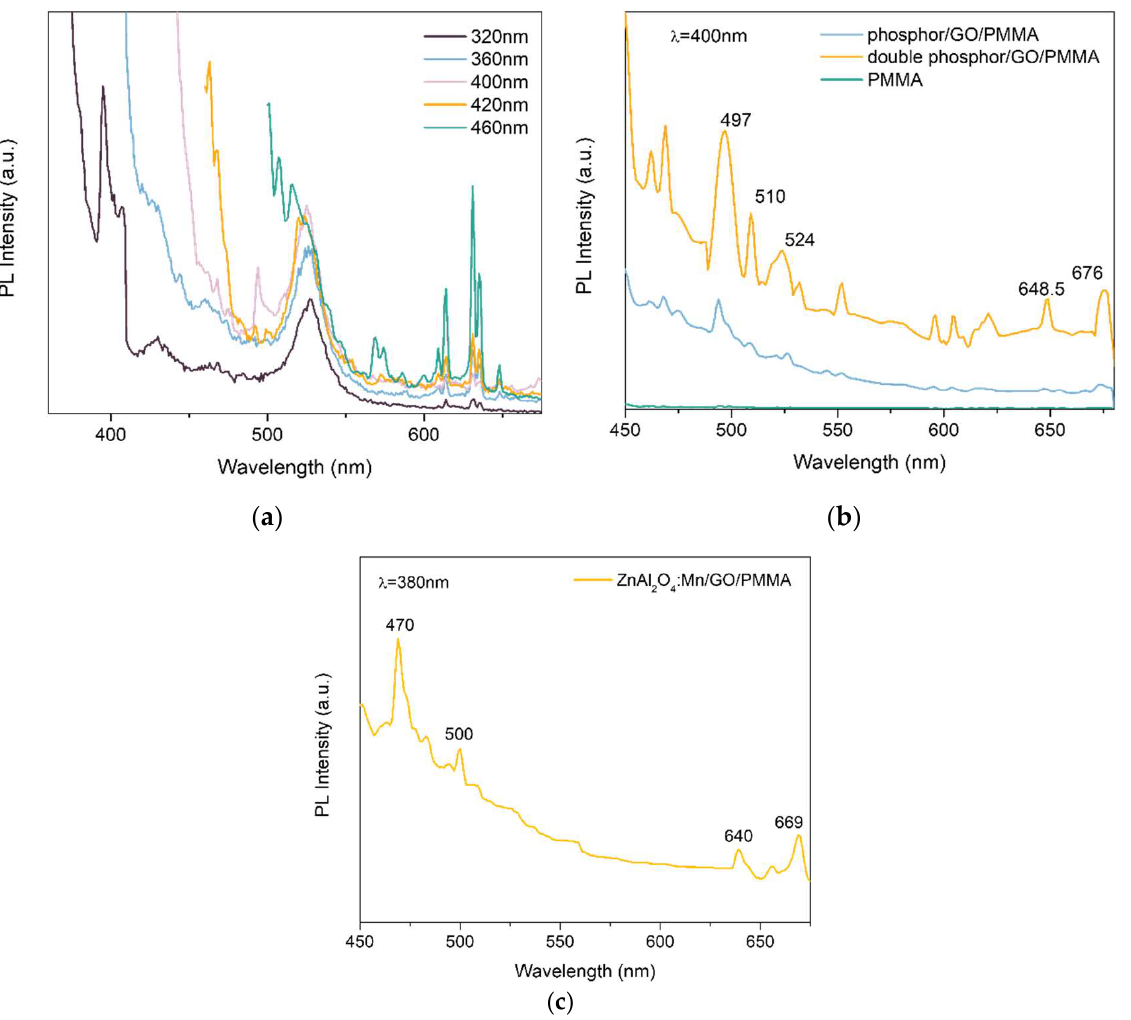
Figure 12. ( a ) PL spectra of ZnAl 2 O 4 : Mn/GO-Br; ( b ) PL spectra of PMMA and ZnAl 2 O 4 : Mn/GO/PMMA excited by 420 nm; ( c ) PL spectrum of ZnAl 2 O 4 :Mn/GO/PMMA excited by 380 nm.